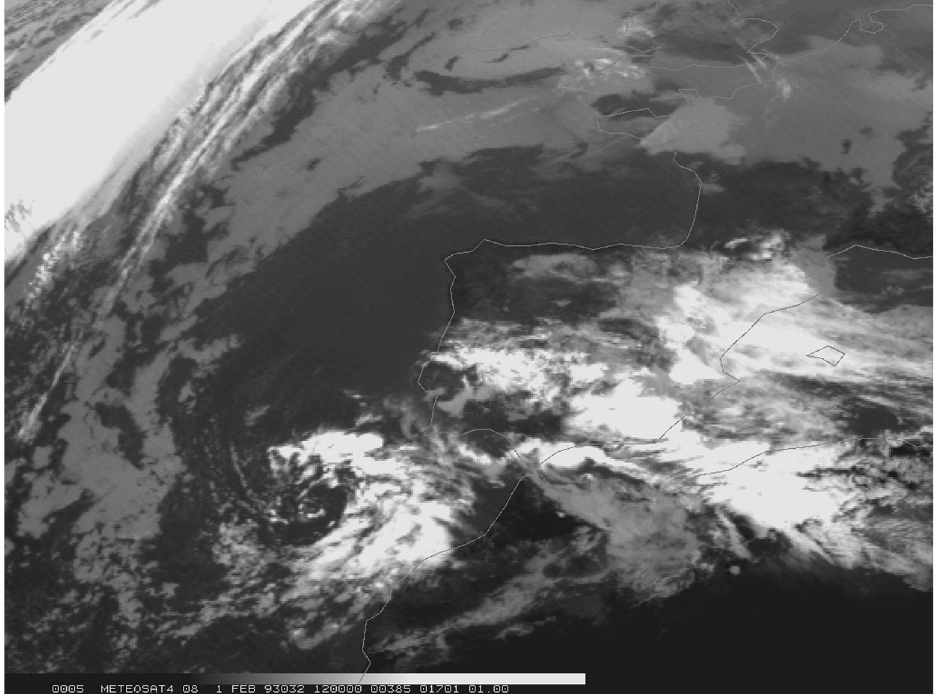
Fig. 9. Meteosat infrared image for 1 February 1993 at 1200 UTC